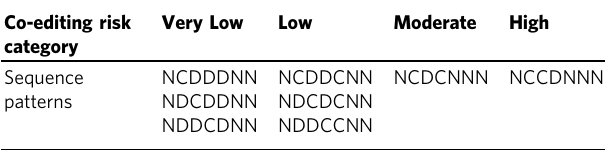
Table 1 Sequence patterns of co-editing risk